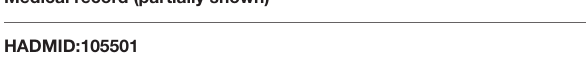
TABLE 1 | An example of a medical